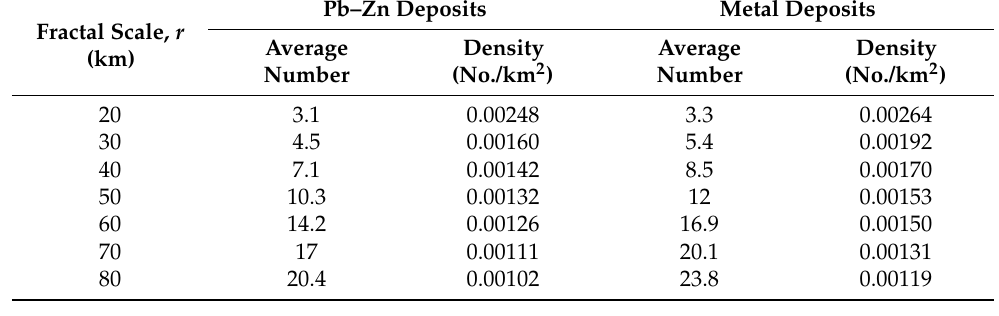
Table 11. Statistics of fractal distribution data of deposit number and density.